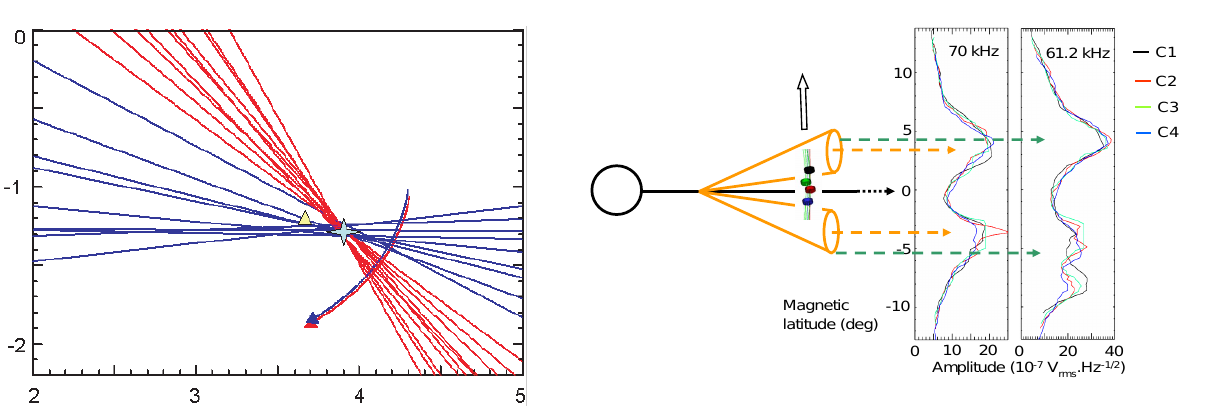
Fig. 4. Left: NTC beams (orange) and constellation configuration at perigee; the arrow denotes the direction of motion. Right: latitudi- nal profiles (in SM coordinates) of the electric field amplitude mea- sured from the four CLUSTER platforms at 70kHz and 61.2kHz. The colour coding is shown on the